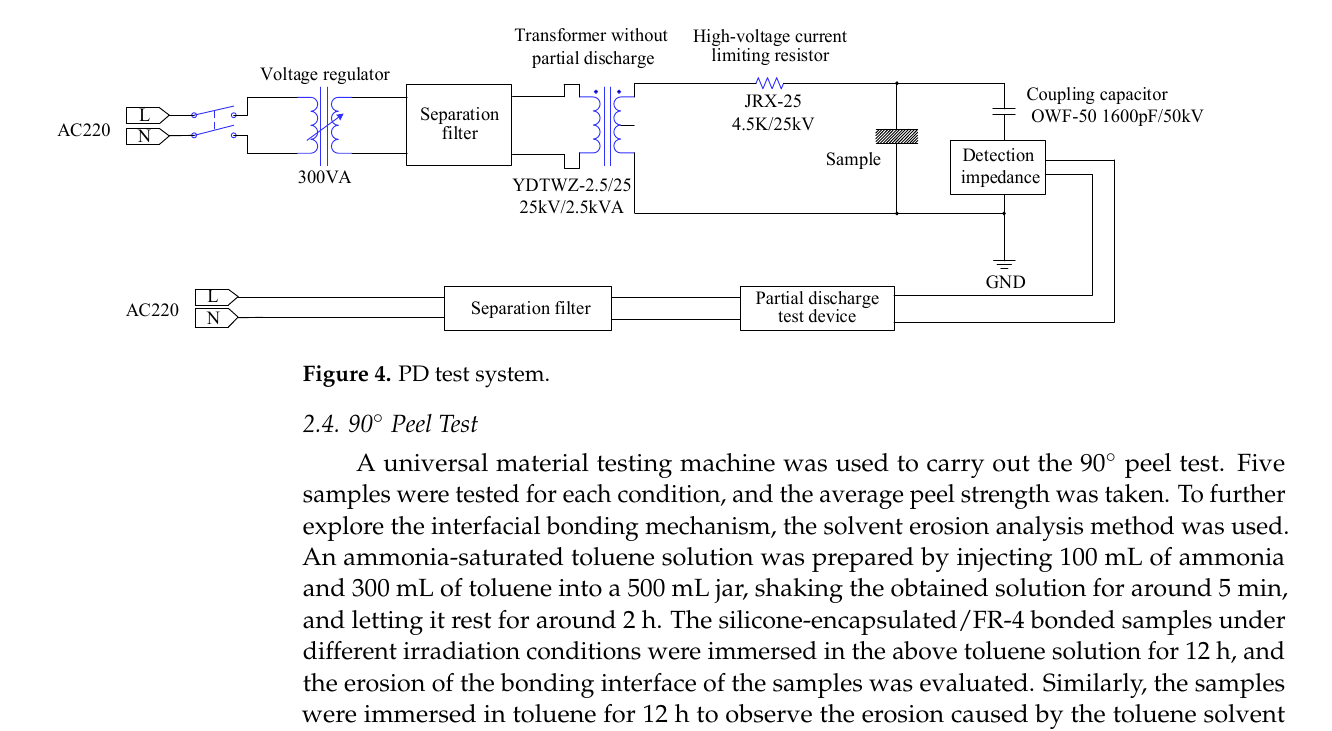
2.3. PD Inception Voltage Test